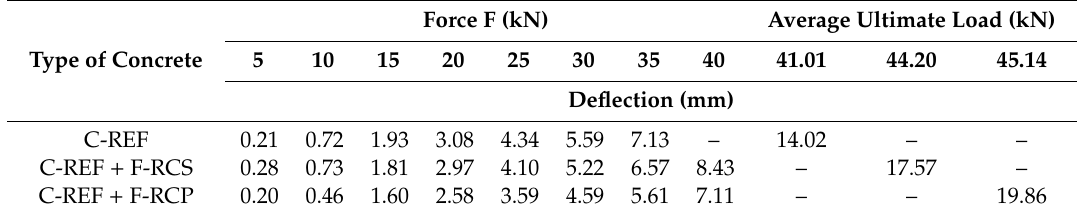
Table 10. Average deflection for the concrete slabs tested.